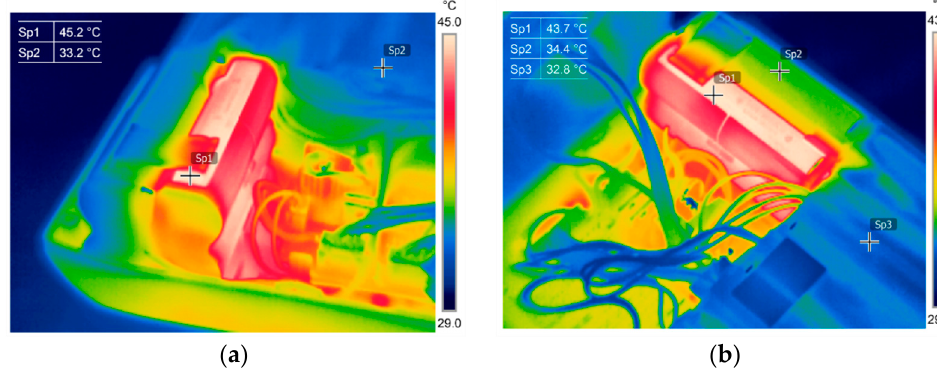
Figure 11. Overheated healthy cells that conduct the overall battery pack current (a view from different perspectives), ( a ) from rear side and ( b ) from top side.